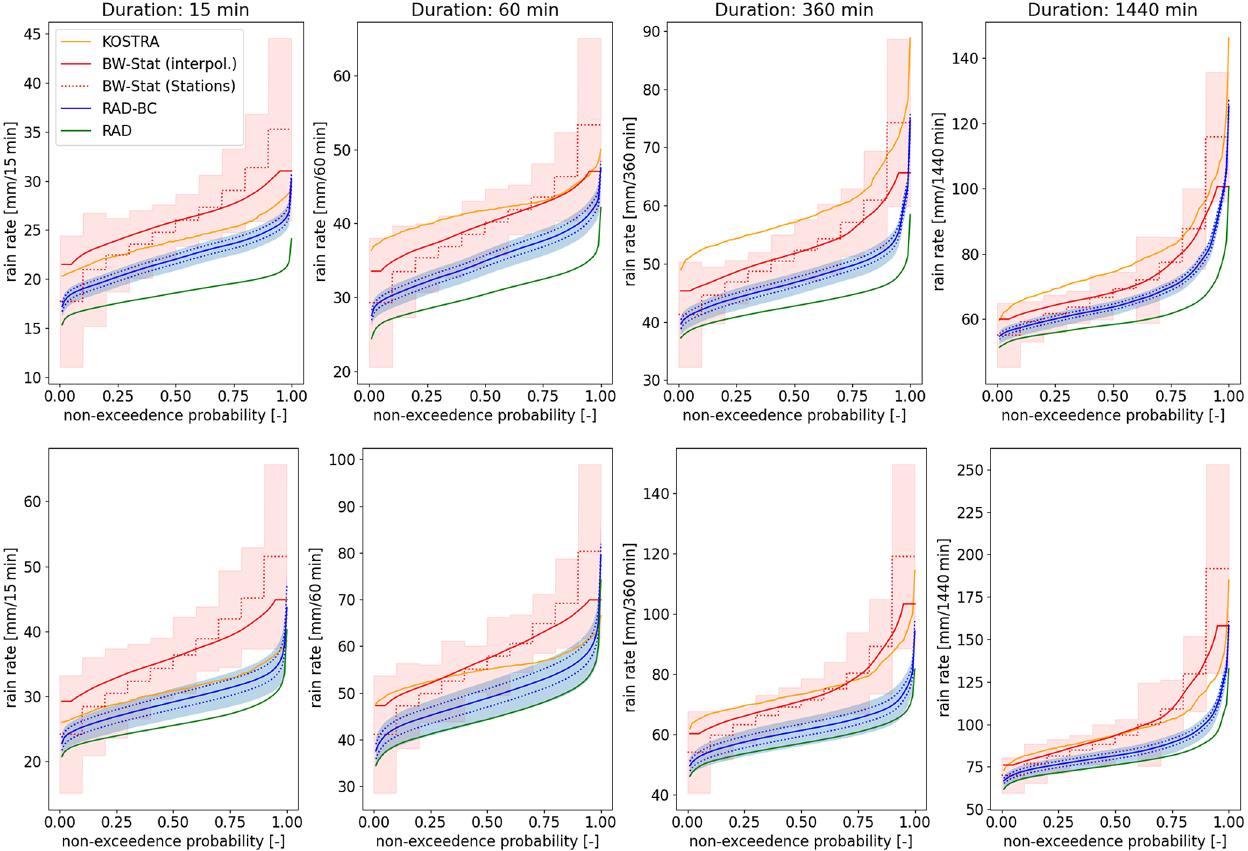
Figure 5. Spatial cumulative frequency distributions (CFDs) of the magnitude of 20-year (upper row) and 100-year (bottom row) design storms for four different event durations and different datasets. The blue shaded range depicts the ensemble uncertainty (5th and 95th percentile of the range from the 1000 bootstraps for each of the five ensemble members). The dotted blue lines in the bottom row represent the range of the five ensemble members (sampling uncertainty, no bootstrapping) only. For comparison we added the interpolation error (RMSE) – red shaded area of the underlying stations (dotted red line) of the BW-Stat dataset. Note that for the RAD, RAD-BC, BW-Stat (interpolated) and KOSTRA dataset, the CFDs are calculated on the gridded data (with fewer grid boxes in KOSTRA), while for the BW-Stat (Stations) data, the stations have been binned in 10 bins. In the latter dataset all stations are included in the CFD while in the gridded BW-Stat no values above/below the 5th/95th percentile are